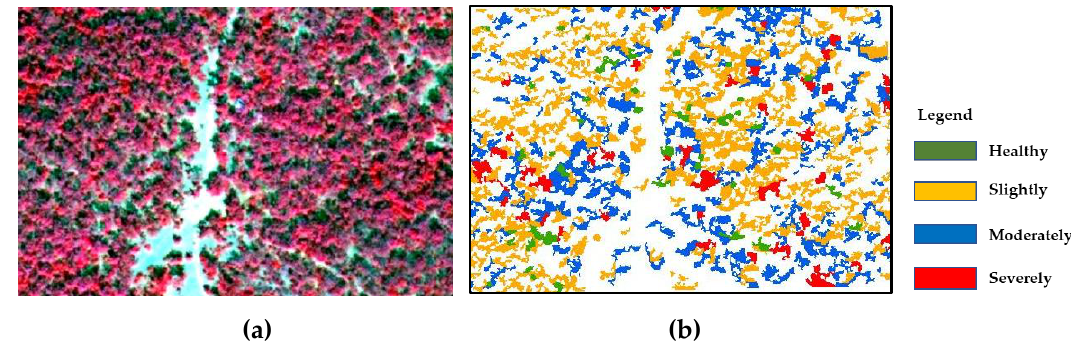
Figure 7. Detailed example of the SDR mapping of Yunnan pine forest. (a) 0.3 m WV-3 pan-sharpened false color image (R: NIR1; G: Red; B: Green); (b) Shoot damage trees mapping based on SDA classifier.